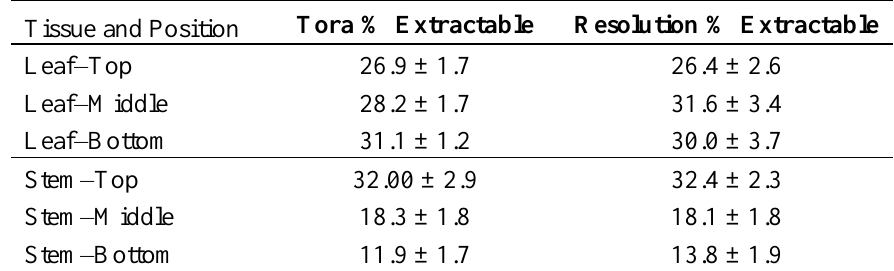
Table 2. Level of extractable metabolite pool from S. viminalis leaf and stem tissue, expressed as a % of total dry